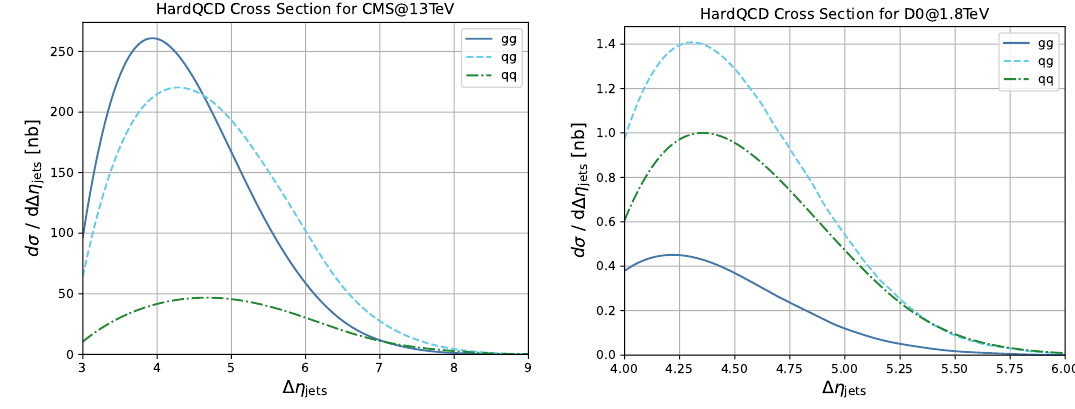
Figure 9 . QCD dijet cross section as a function of ∆ η jets separated in its qq → qq , gg → gg , and qg → qg components. The left panel is for 13 TeV collisions with the CMS selection requirements, whereas the right panel is for 1.8 TeV collisions with the D0 selection